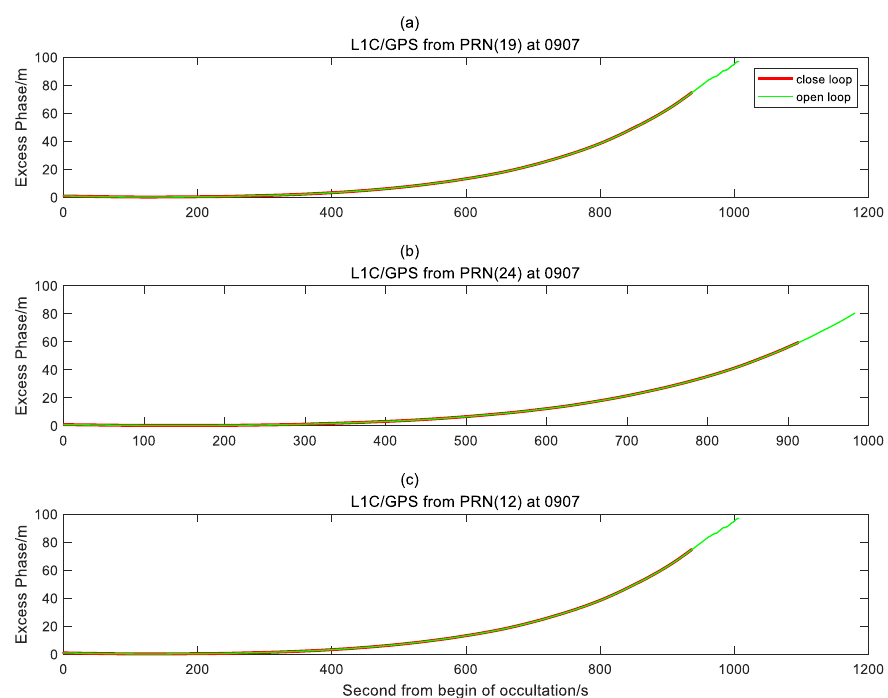
Figure 7. Excess phase retrieved from observations of L1C / GPS in OL / closed-loop tracking mode. Red / green lines represent the phases in closed-loop / OL tracking mode, respectively. ( a ) G19 / GPS occultation; ( b ) G24 / GPS occultation; and ( c ) G12 / GPS occultation.